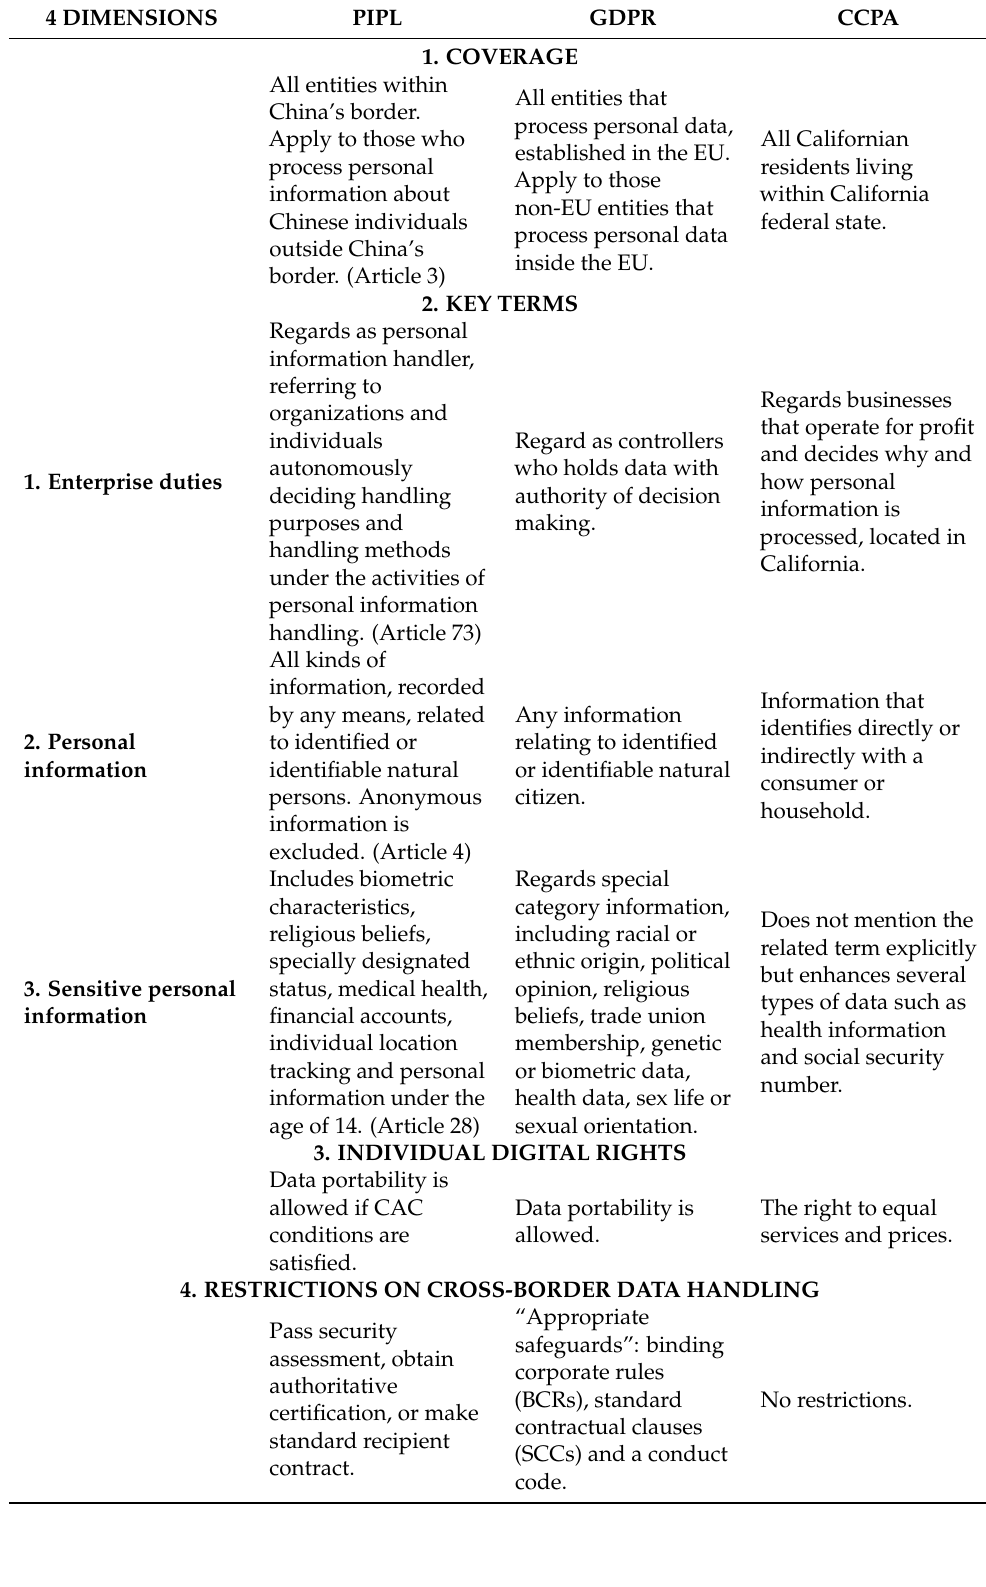
Table 2. Comparing three data privacy regulations through four